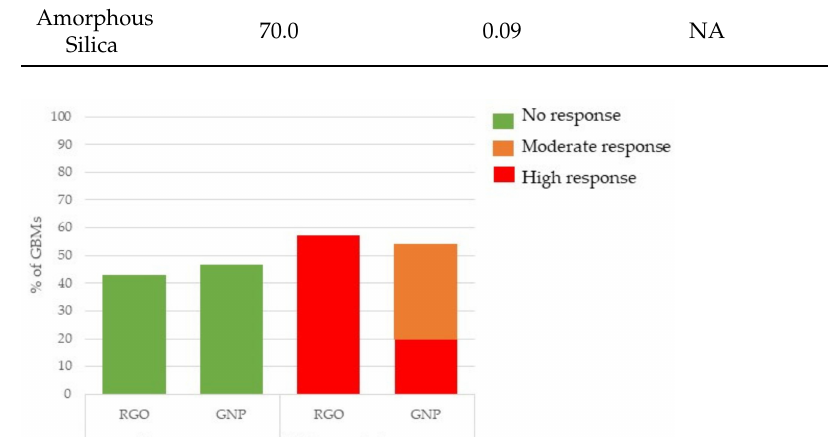
Figure 1. Cytotoxicity classification depending on the GBM type. Three independent experiments were performed, each in quadruplicate and the activity of the released LDH was reported to that of negative control cells (incubated without nanoparticles), then we considered the distribution of GNP and RGO in the groups showing no, moderate or high